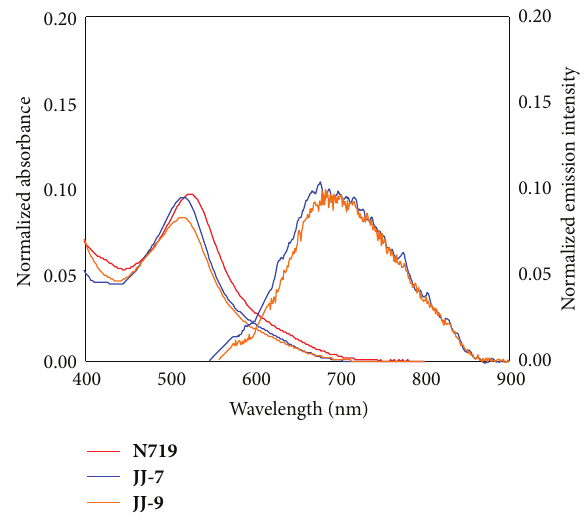
Figure 4: Absorption and emission spectra of JJ-7 (blue line), JJ-9 (orange line), and N719 (red line) in